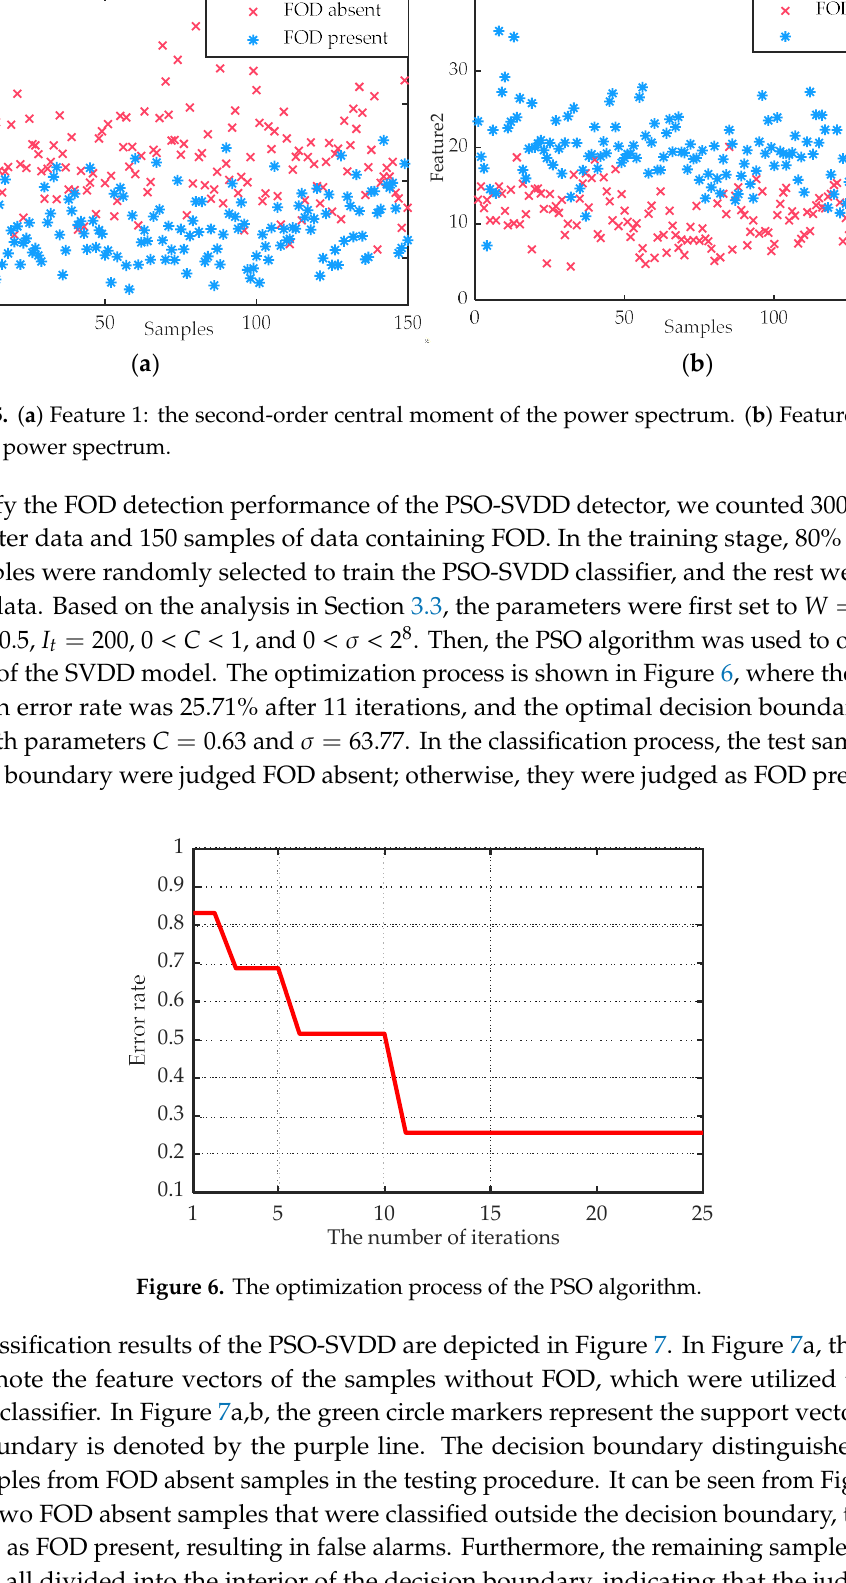
Figure 4. ( a ) Amplitude spectrum with FOD present. (b ) Amplitude spectrum with FOD absent.